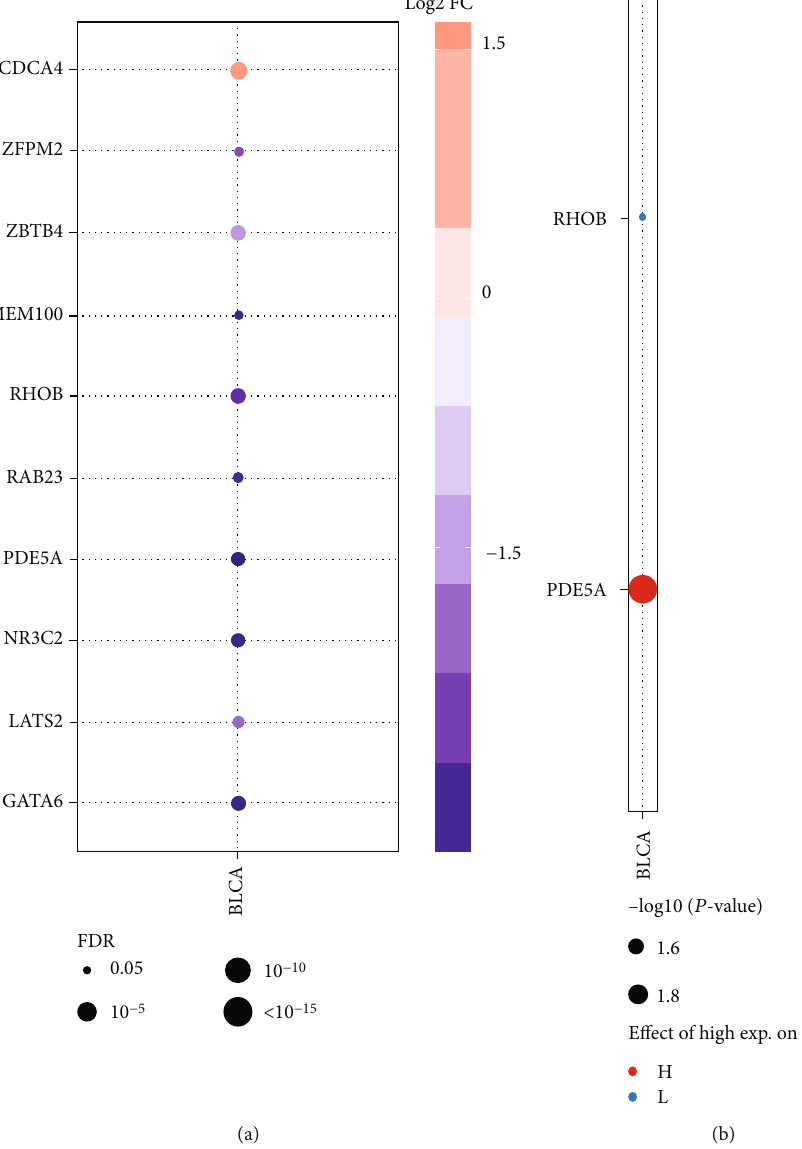
Figure 11: Expressions of the hub genes across cancers. (a) Results of the hub gene expression between tumor and normal groups. (b) Results of the hub gene expression in the survival with diverse cancer types. The signi fi cant di ff erence was under the condition of P value <